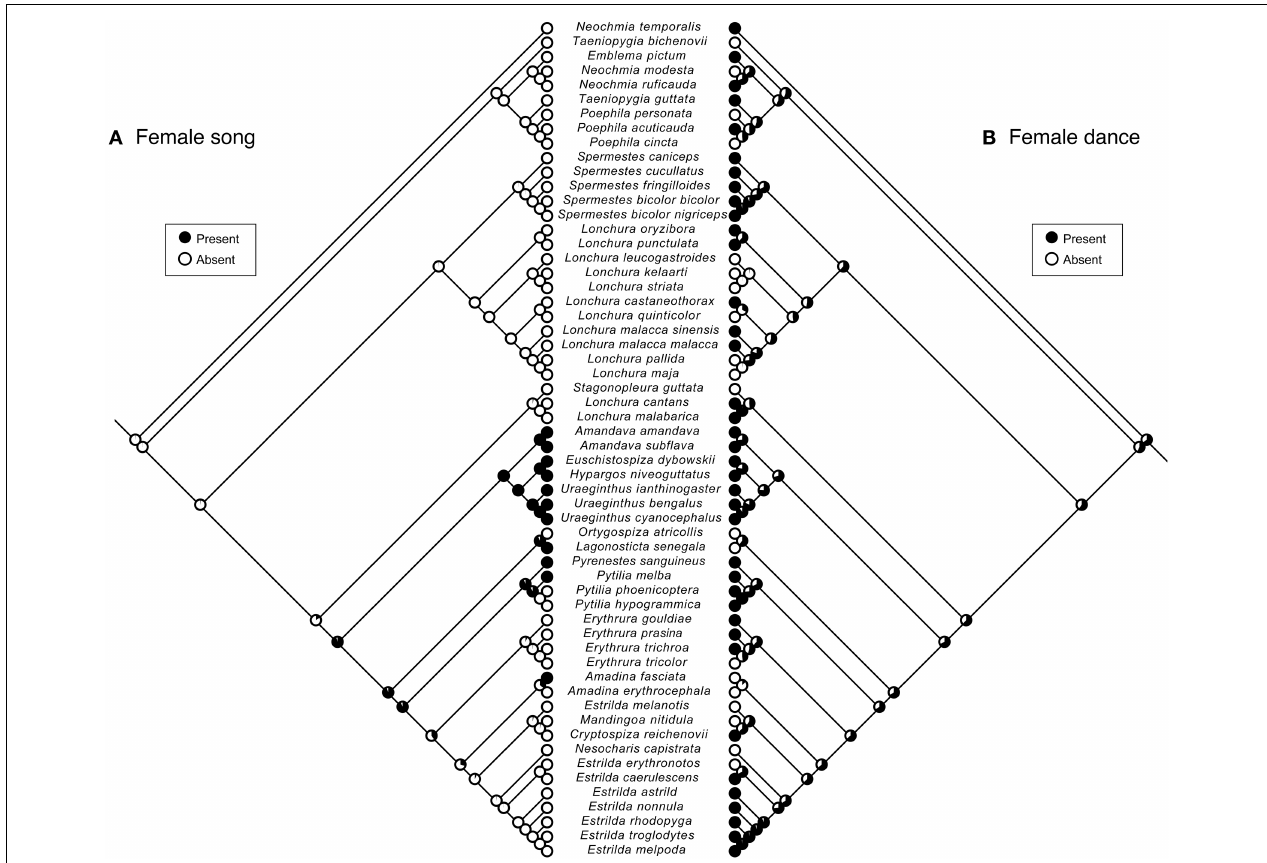
FIGURE 3 | Ancestral reconstruction of behavioral sexual signals in females. Maximum-likelihood reconstruction of ancestral states for the evolution of female song (A) and dance (B) in Estrildid finches, as shown along the phylogeny.